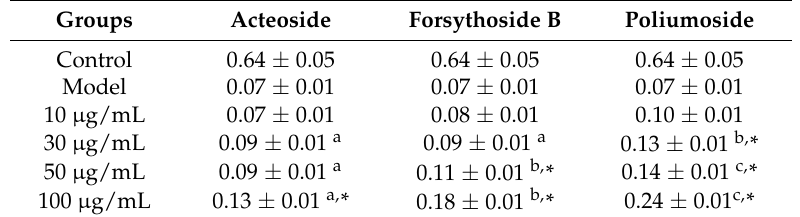
Table 2. The A 490nm of acteoside and its derivatives towards H 2 O 2 -damaged MSCs in MTT assay.